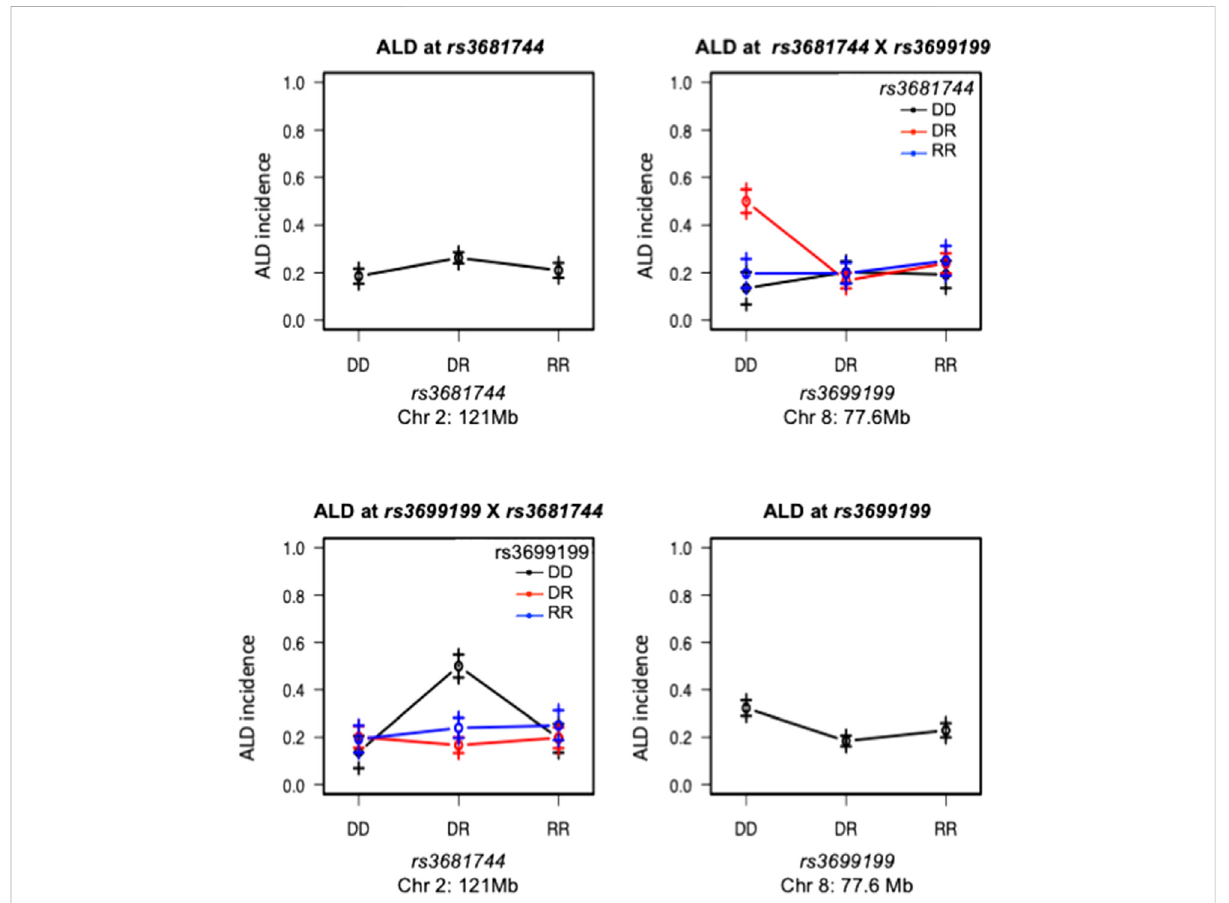
FIGURE 4 Interaction between Chromosomes 2 and 8 was plotted for ALD incidence. Tope left and lower right panels are effect plot of Chr 2 and Chr 8 respectively, same as in Figure 2. Top right panel: Chr 8 genotype is on the x -axis, Chr 2 genotype is shown as group points. ALR allele on Chr 8dominantlysuppressesthesensitivity,thereforethehighestALDincidenceisseenintheco-existenceofhomozygousNODgenotypeonChr8and heterozygosity on Chromosome 2; Bottom left panel, showing the same interaction result with Chr 2 genotype on the x -axis and Chr 8 genotype as group points. The interaction is signi fi cant as shown in Table 3. DD: homozygous for NOD; DR: heterozygous for NOD/ALR; RR: homozygous for